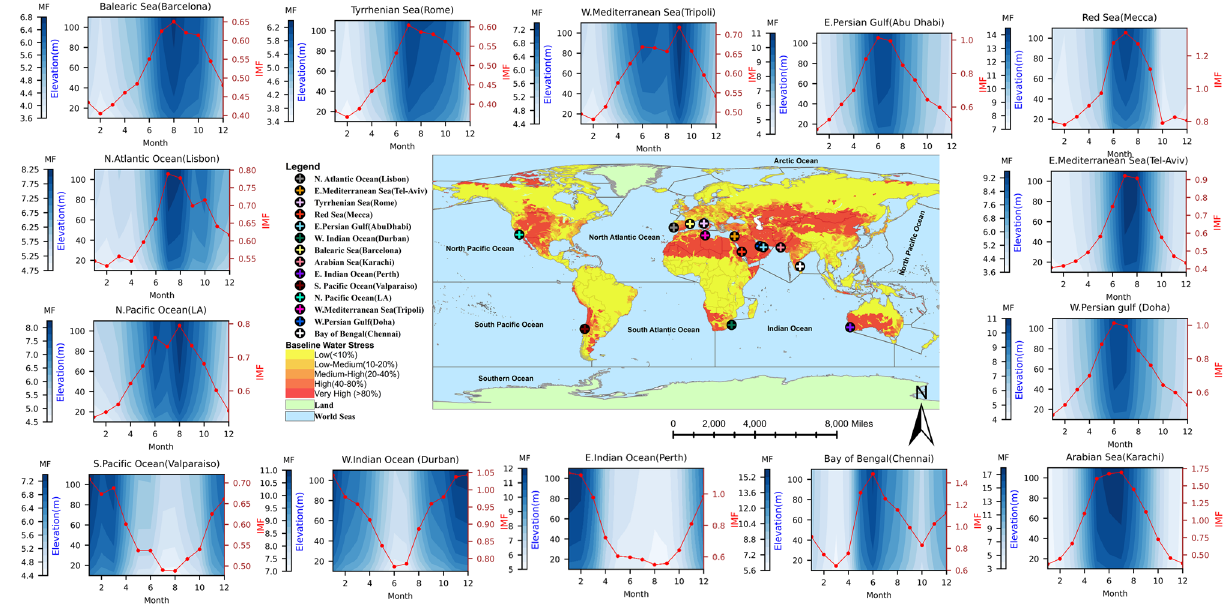
Figure 2. The location of the 14 study sites over the ocean closest to a dominant population center is depicted on a map of water stress (center). The variation of moisture flux through an atmospheric column from 10 to 110 m above mean sea level is also shown for each of the locations. The contour plots and line graph illustrate the change in daily moisture flux as a function of height and the monthly distribution of available water vapor, respectively. For each location, monthly averages (in red) of moisture flux (million kg/m/day) are overlain on daily moisture flux (thousand kg/m 2 day)) through the vertical column (in blue). Spatiotemporal variability of moisture flux (thousand kg/m 2 day) and integrated moisture flux (million kg/m/day). The plots